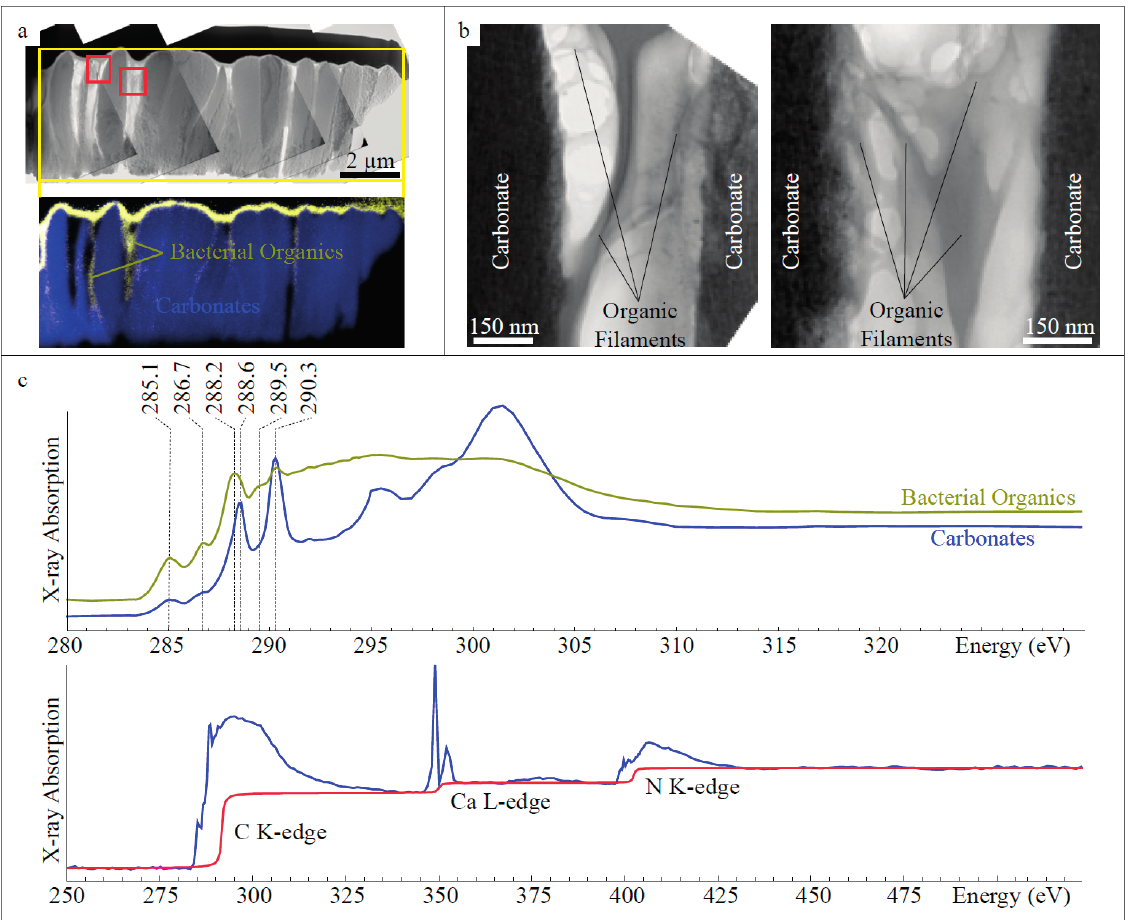
Figure 6. Organic composition of the investigated contemporary and fossilized epibiotic calcifying bacterial colonies. ( a ) Top: TEM image of an ultrathin FIB foil of sample extracted from a contemporary epibiotic calcifying bacterial colony (red squares indicate the location of TEM images shown in (b)). Bottom: STXM compositional map of the ultrathin foil showing the spatial distribution of carbonates (blue) and organics (yellow). ( b ) TEM images of areas of the ultrathin FIB foil shown in (a). Organic filaments appear in dark. ( c ) Top: C-XANES spectra of organics and carbonates composing the ultrathin FIB foil shown in (a) (peaks at 285.1, 286.7, 288.2, 288.6, 289.5 and 290.3 eV are attributed